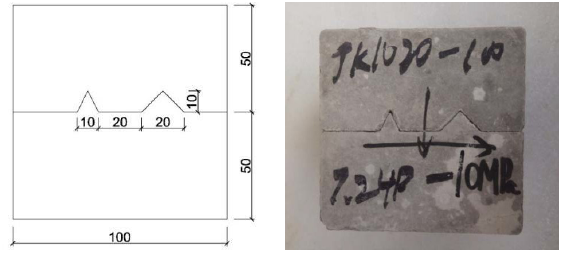
Figure 4: Typical double saw-tooth joint